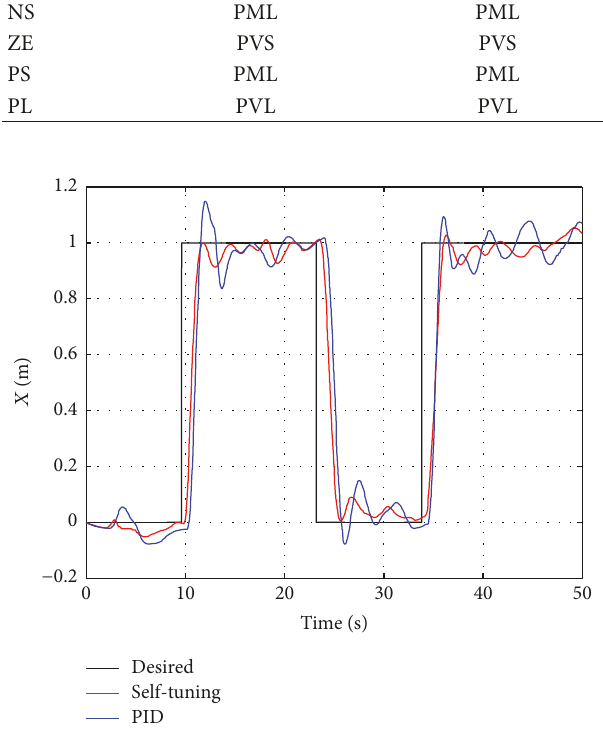
Figure 17: Quadrotor 𝑥 position under payload with variable weight.